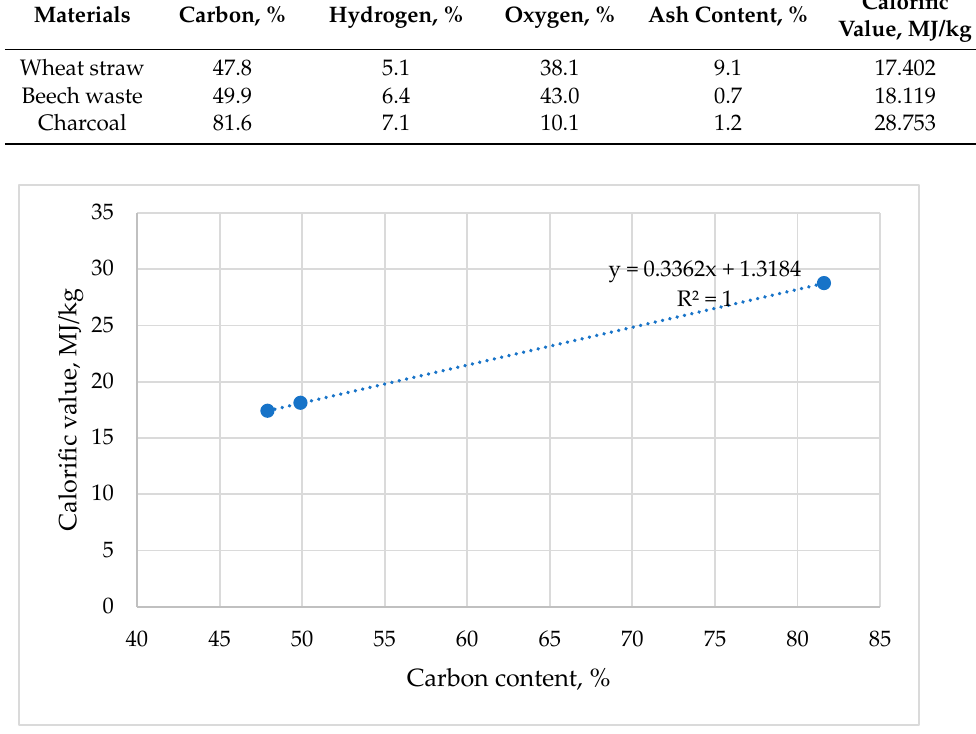
Figure 6. The influence of carbon content on the calorific value of straw.